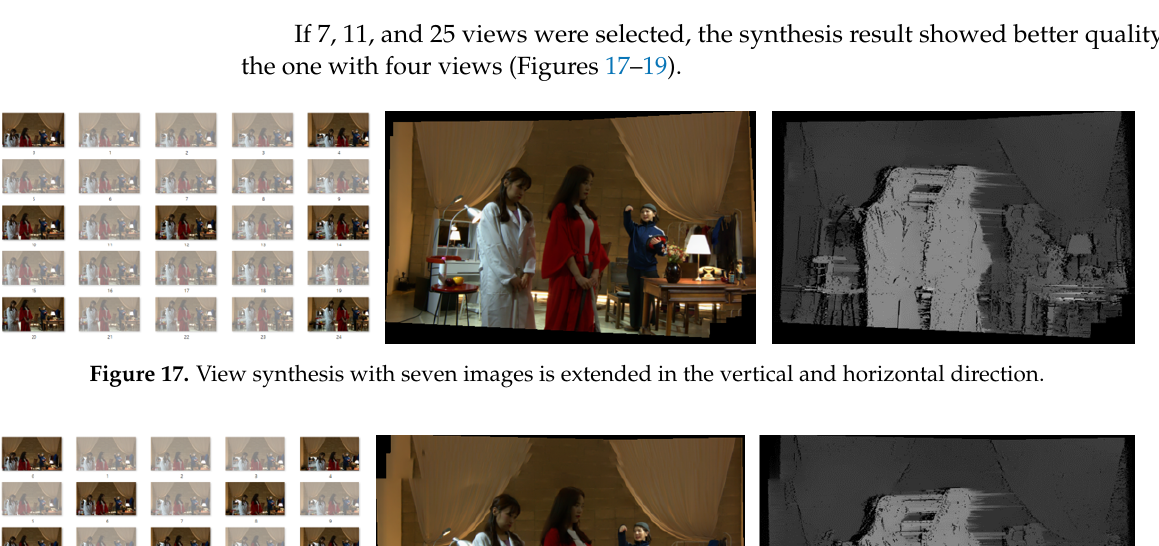
Figure 16. View synthesis with four images is extended in the vertical and horizontal direction.